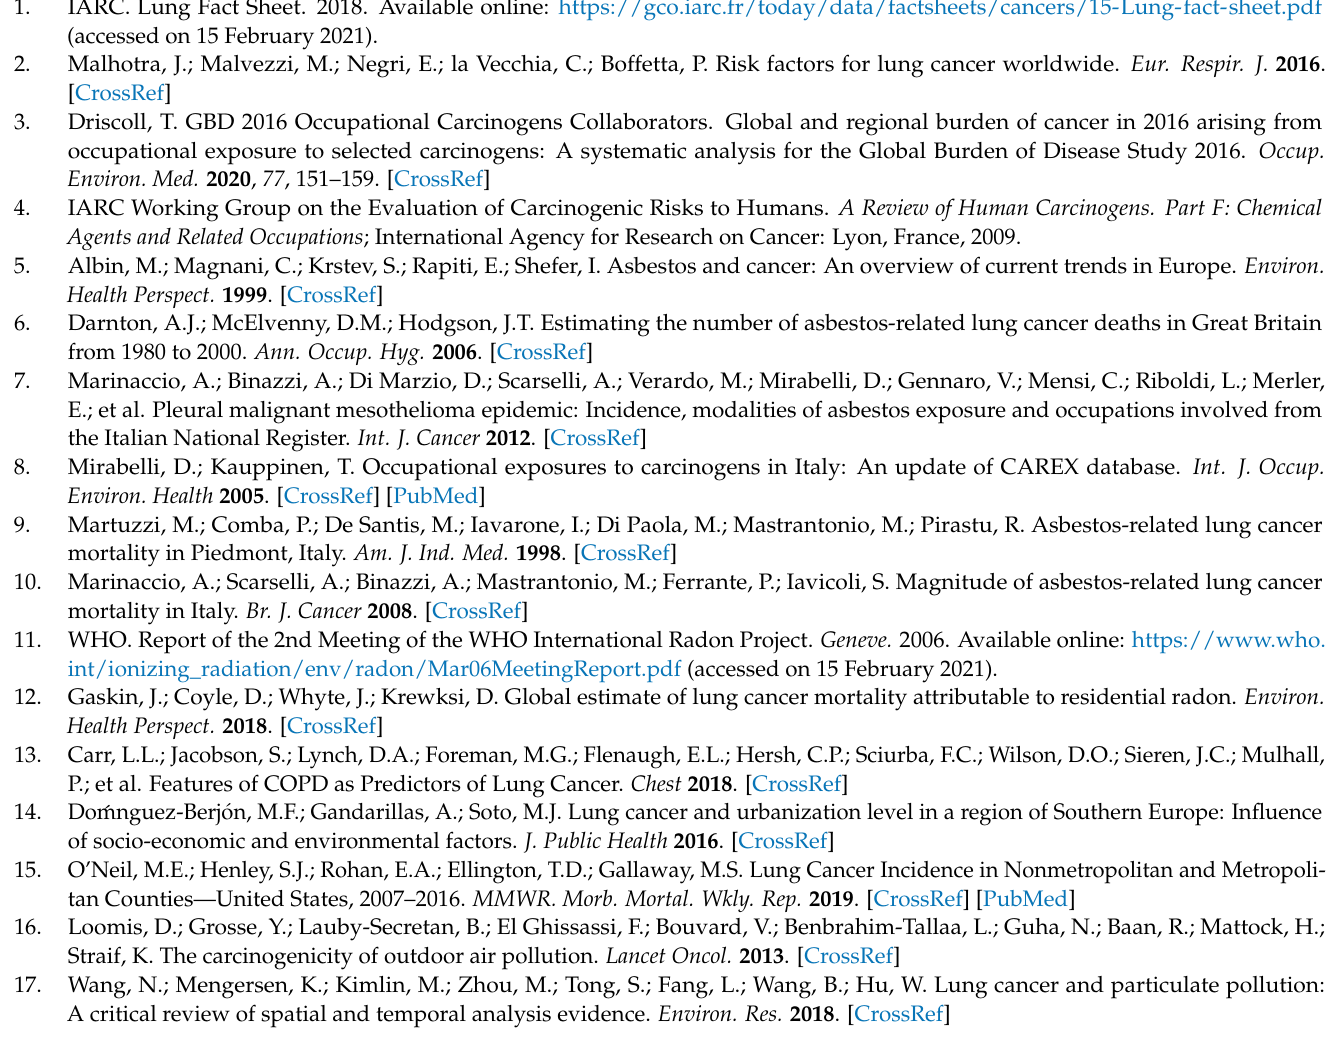
Table S1: Increment Risk [%] (95% CI) of lung cancer (LC) mortality by Deprivation and Urbanization. 2006–2015, Table S2: Full model for LC death counts. Males, years 2006–2015, parameter estimates, Table S3: Full model for LC death counts. Females, years 2006–2015, parameter estimates, Table S4: Reduced model for LC death counts. Males, years 2006–2015, parameter estimates, Table S5: Reduced model for LC death counts. Females, years 2006–2015, parameter